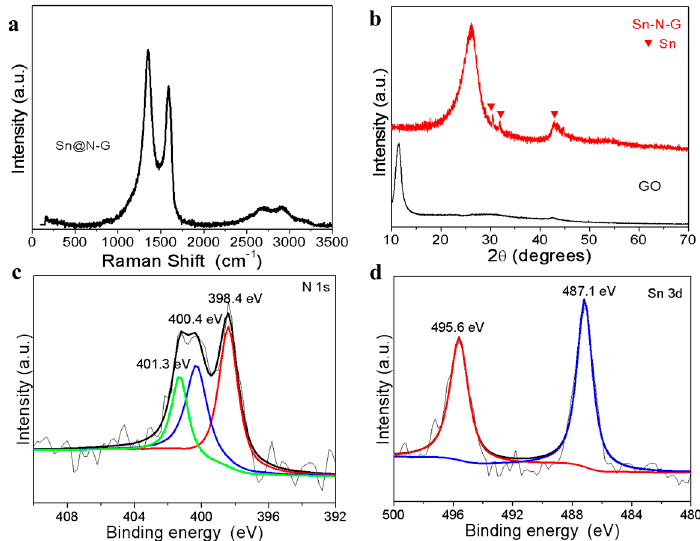
Figure 3. ( a ) Raman spectrum of Sn@N-G composite. ( b ) X-ray photoelectron spectroscopy (XRD) patterns of grapheme oxide (GO) and Sn@N-G, ( c ) X-ray photoelectron spectroscopy (XPS) spectrum of N1s of Sn@N-G composite. ( d ) XPS spectrum of Sn 3D Sn@N-G composite.